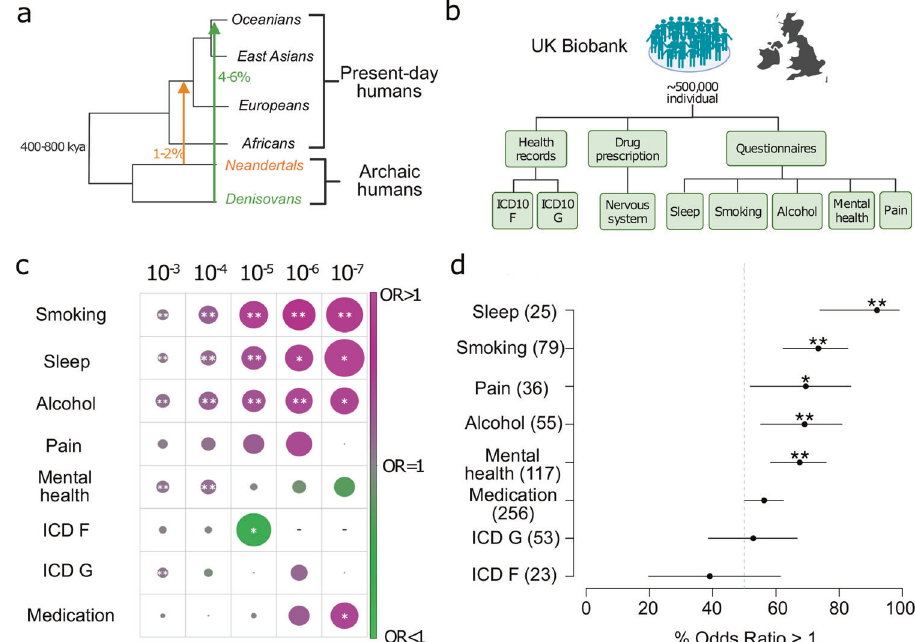
Fig. 1 The proportional association of Neandertal DNA with mental and behavioral disease and non-disease phenotypes. a Some of the genetic variation in present-day people is a result of the admixture with archaic humans such as Neandertals and Denisovans ~55,000 years ago. Consequently, ~2% of the genomes of present-day non-Africans are of Neandertal ancestry and an additional 5% of the genomes of Oceanians derived from Denisovans. Approximately 40% of the genome of Neandertals can be reconstructed in people today and tested for its phenotypic potential in genome-wide association studies. b Overview of UK Biobank GWAS summary statistics for behavioral phenotypes that were included in this study. Included phenotypic information was derived from medical records that include diagnosis and drug prescription information and questionnaires related to behavioral patterns. c The combined numbers of associations of tag aSNPs with all phenotypes from one of eight tested groups in the UK Biobank ( y -axis) was put in relation to the average of the combined numbers of associations for 1,000 sets of frequency-matched non-archaic tag SNPs. The resulting average odds ratios based on fi ve signi fi cance cutoffs (shown on top) are displayed and color-coded and shown in size proportional to the corresponding log of the average odds ratio. Instances where tag aSNPs showed signi fi cant deviations from the number of phenotype associations of their non-archaic counterparts were highlighted (* P < 0.05, **FDR < 0.05). d The average odds ratio between the number of associations of tag aSNPs compared to the number of associations for 1,000 sets of frequency-matched non-archaic tag SNPs for each individual phenotype from eight phenotype groups from the UK Biobank were calculated. The proportion of these odds ratios that are larger than one for a given phenotype group (y -axis, number of tests across all signi fi cance cutoffs for each group shown in parenthesis), together with the binomial 95% con fi dence intervals are displayed. Phenotype groups for which this proportion is signi fi cantly different from the random expectation of 50% are highlighted (* P < 0.05, **FDR <